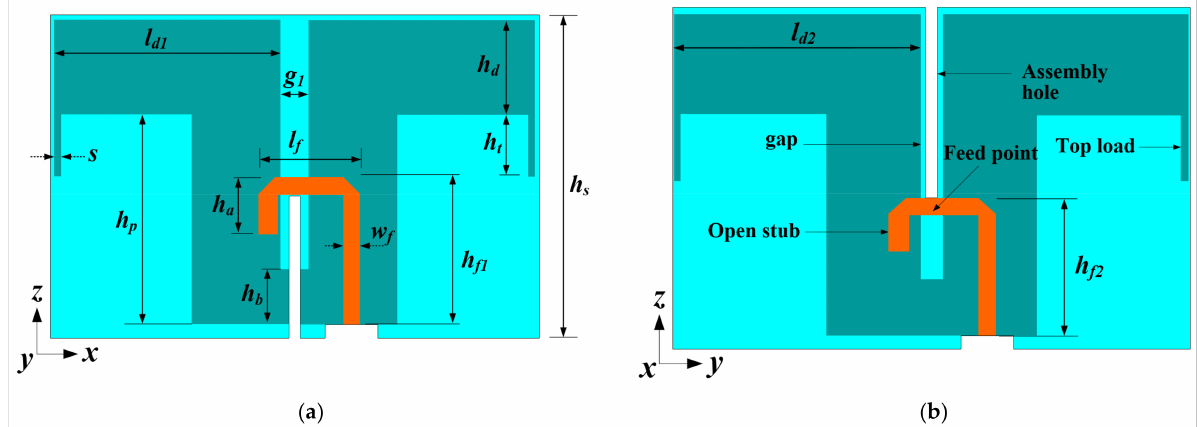
Figure 2. Geometry of the radiating elements with integrated balun feedlines; ( a ) +45-deg. (Port 1) and ( b ) − 45-deg. (Port 2) linearly polarized dipoles.